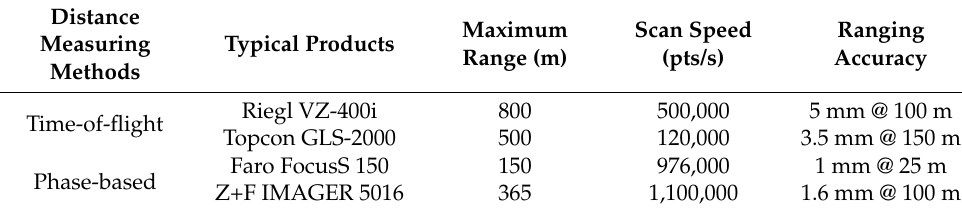
Table 1. Comparison of different type laser scanners (specifications offered by